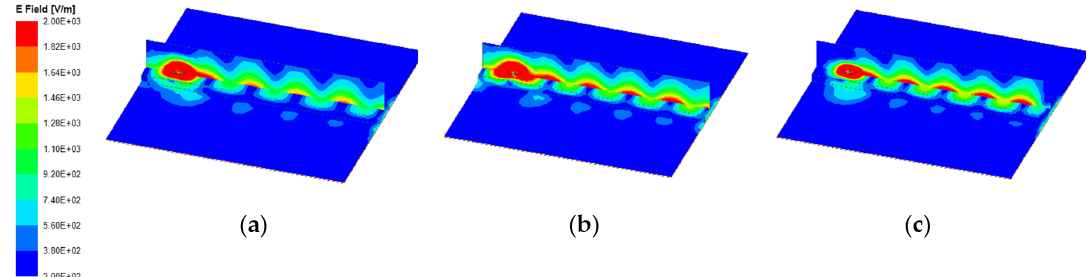
Figure 8. electric field (E-field) distributions of the proposed antenna and in free space at different frequencies: ( a ) 5.8 GHz; ( b ) 6 GHz; ( c ) 6.2 GHz.